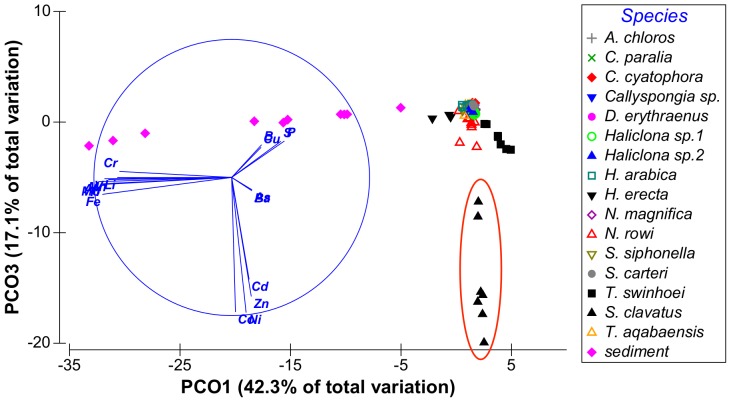
Distribution of sponge and sediment samples along PCOII vectors 1 and 3, explaining 59% of all variation between samples.Samples of interest are circled in red.